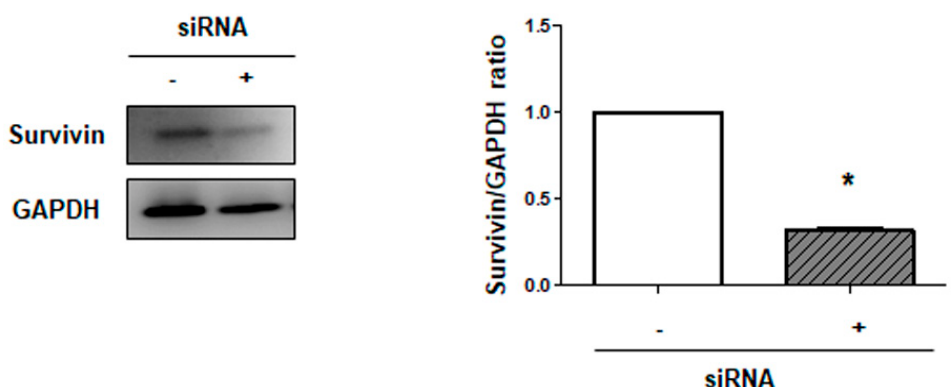
Figure A4. Validation of siRNA targeting survivin in cardiomyocytes. H9c2 cells were transfected with siRNA (50 nM) targeting survivin. The protein levels of survivin and GAPDH were measured by Western blotting ( n = 5). * Significant difference compared to the control ( p < 0.05).